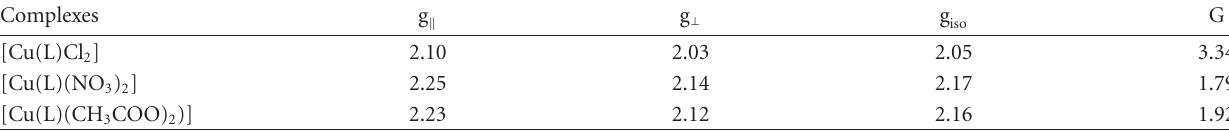
Table 4: EPR spectral data of the Cu(II) complexes.